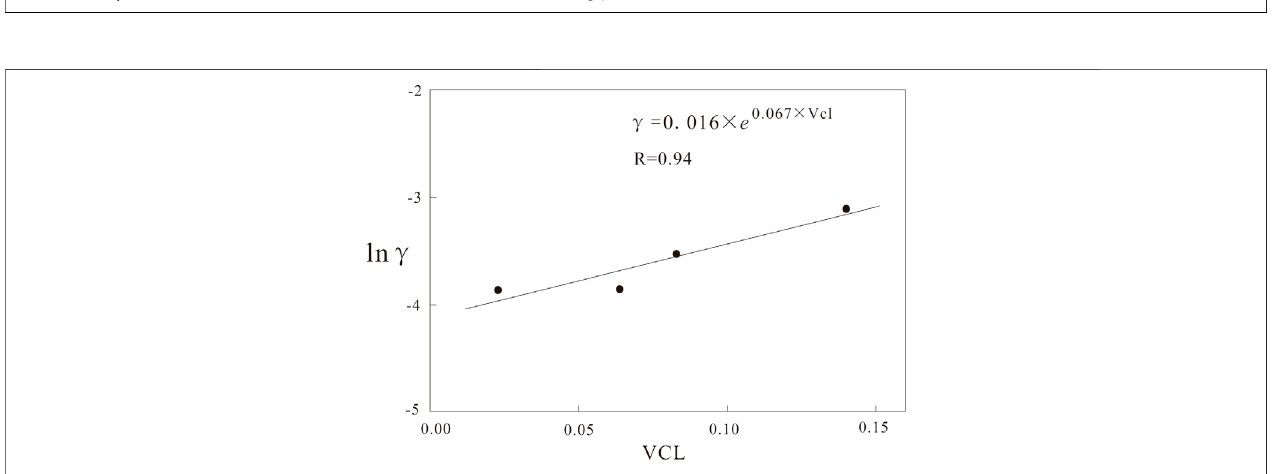
FIGURE 16 | Variation in the static brittleness index under different con fi ning pressures.